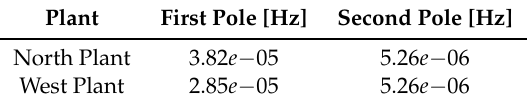
Table 1. Plant properties for actuator and laser heating